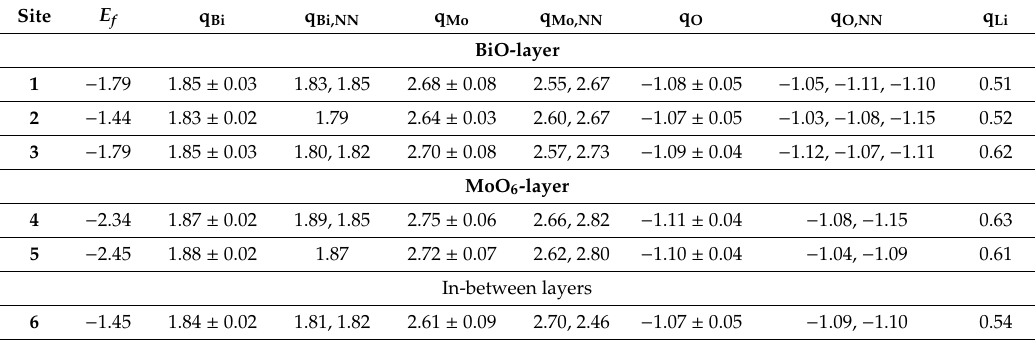
Table 2. Defect formation energy (E f ) in eV, average Bader charges (q) with standard deviation, and unique Bader charge for nearest neighbor (NN) atoms to Li site (in e) for insertion of a single Li at di ff erent lattice sites. Graphical representation of interstitial site numbering is presented in Figure